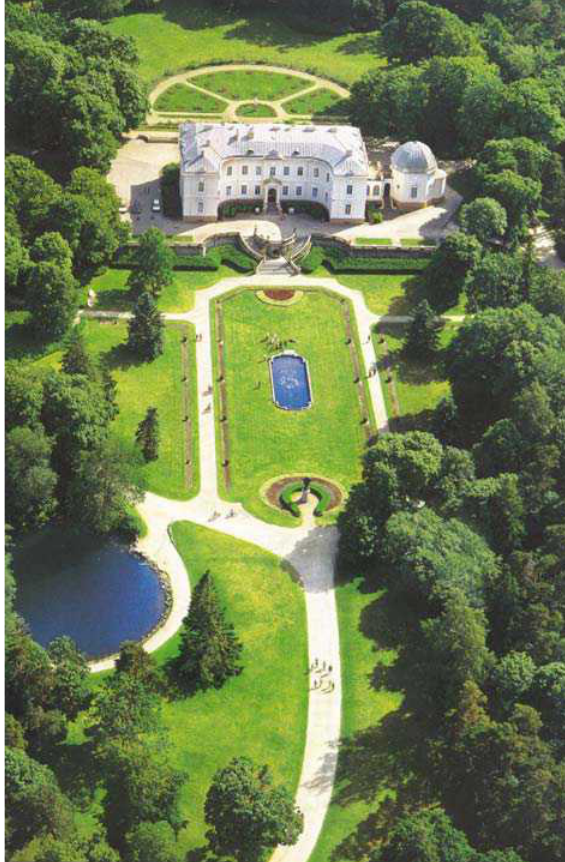
struktūros elementas Fig 4 . Old park of Kretinga – the most important element of the town‘s landscape